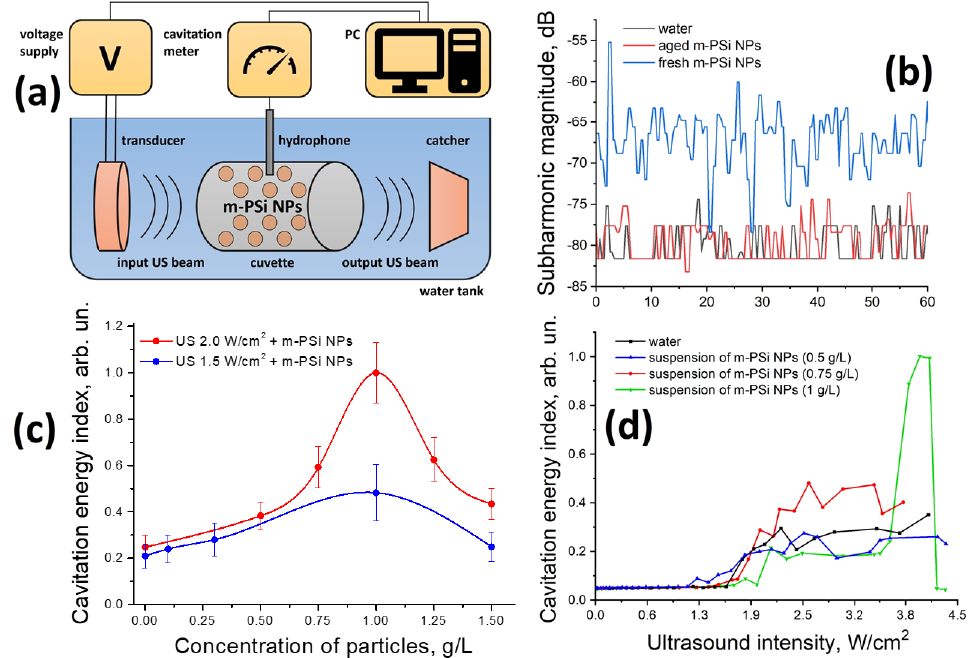
Figure 2. Investigation of the cavitation-sensitizing properties of m-PSi NPs: ( a ) Schematic of acoustic setup built for the cavitation activity measurement. ( b ) f/2 subharmonic magnitude in water ( blue line ), freshly prepared aqueous suspension of m-PSi NPs ( blue line ), and suspension of m-PSi NPs aged for several weeks at the concentration of 1 mg/mL ( red line ) vs. time of exposure to the ultrasound of intensity 2 W/cm 2 . ( c ) Cavitation energy index vs. concentration of m-PSi NPs in the freshly prepared suspension under exposure to the ultrasound irradiation with intensities of 1.5 W/cm 2 (blue circles) and 2.0 W/cm 2 (red circles). Vertical bars correspond to the RMSE, and continuous curves are Bezier splines as guides for eyes. ( d ) Cavitation energy index vs. ultrasound intensity in water ( black line ) and freshly prepared suspensions of m-PSi NPs at a concentration of 0.5 ( blue line ), 0.75 ( red line ), and 1 ( green line ) g/L.